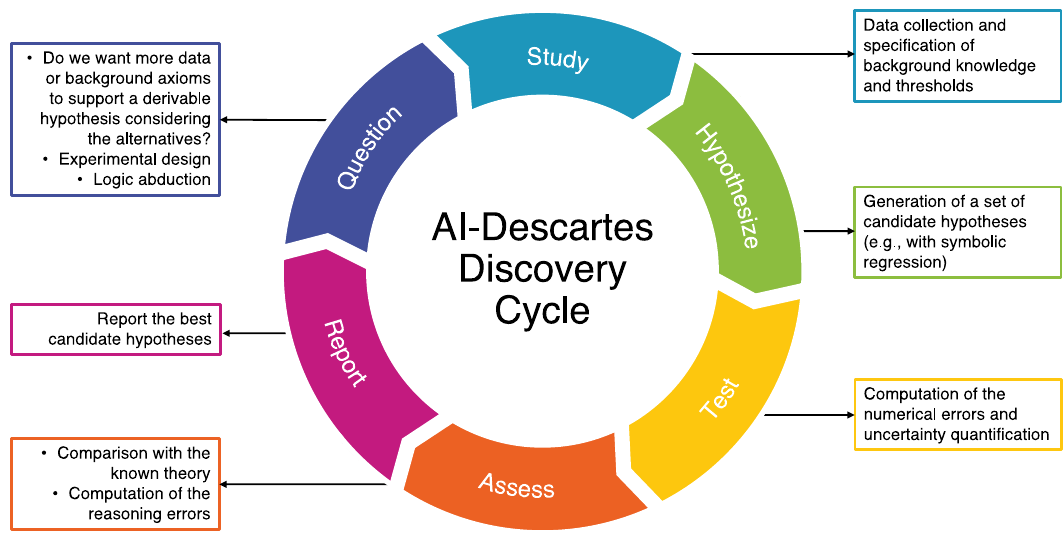
Fig. 2 | An interpretation of the scienti fi c method as implemented by our system. The colors match the respective components of the system in Fig.